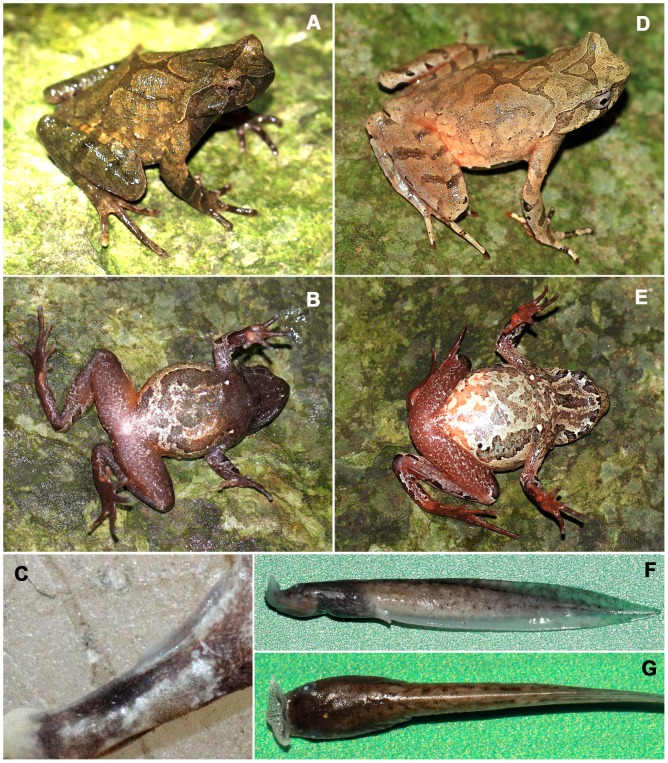

Xenophrys lini sp. nov.A. Dorsolateral view of the live adult male Xenophrys lini
sp. nov holotype SYS a001420. B: Ventral view of the live holotype. C: A clump of tiny black nuptial spines on the thumb of the preserved holotype. D: Dorsolateral views of the live adult female paratype SYS r0001423. E: Foot with wide lateral fringes and rudimentary webbings on the toes in paratype SYS a002372. F and G: Lateral and dorsal view of X. lini
sp. nov. tadpole at stage 32th in preservative. Photographed by YYW.